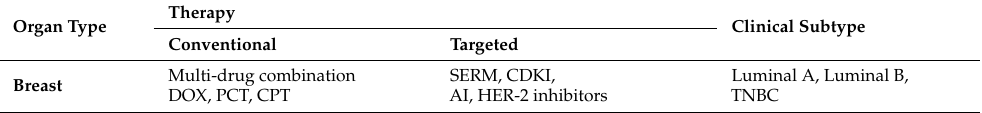
Table 2. Conventional chemo-endocrine therapy and targeted therapy for breast cancer.